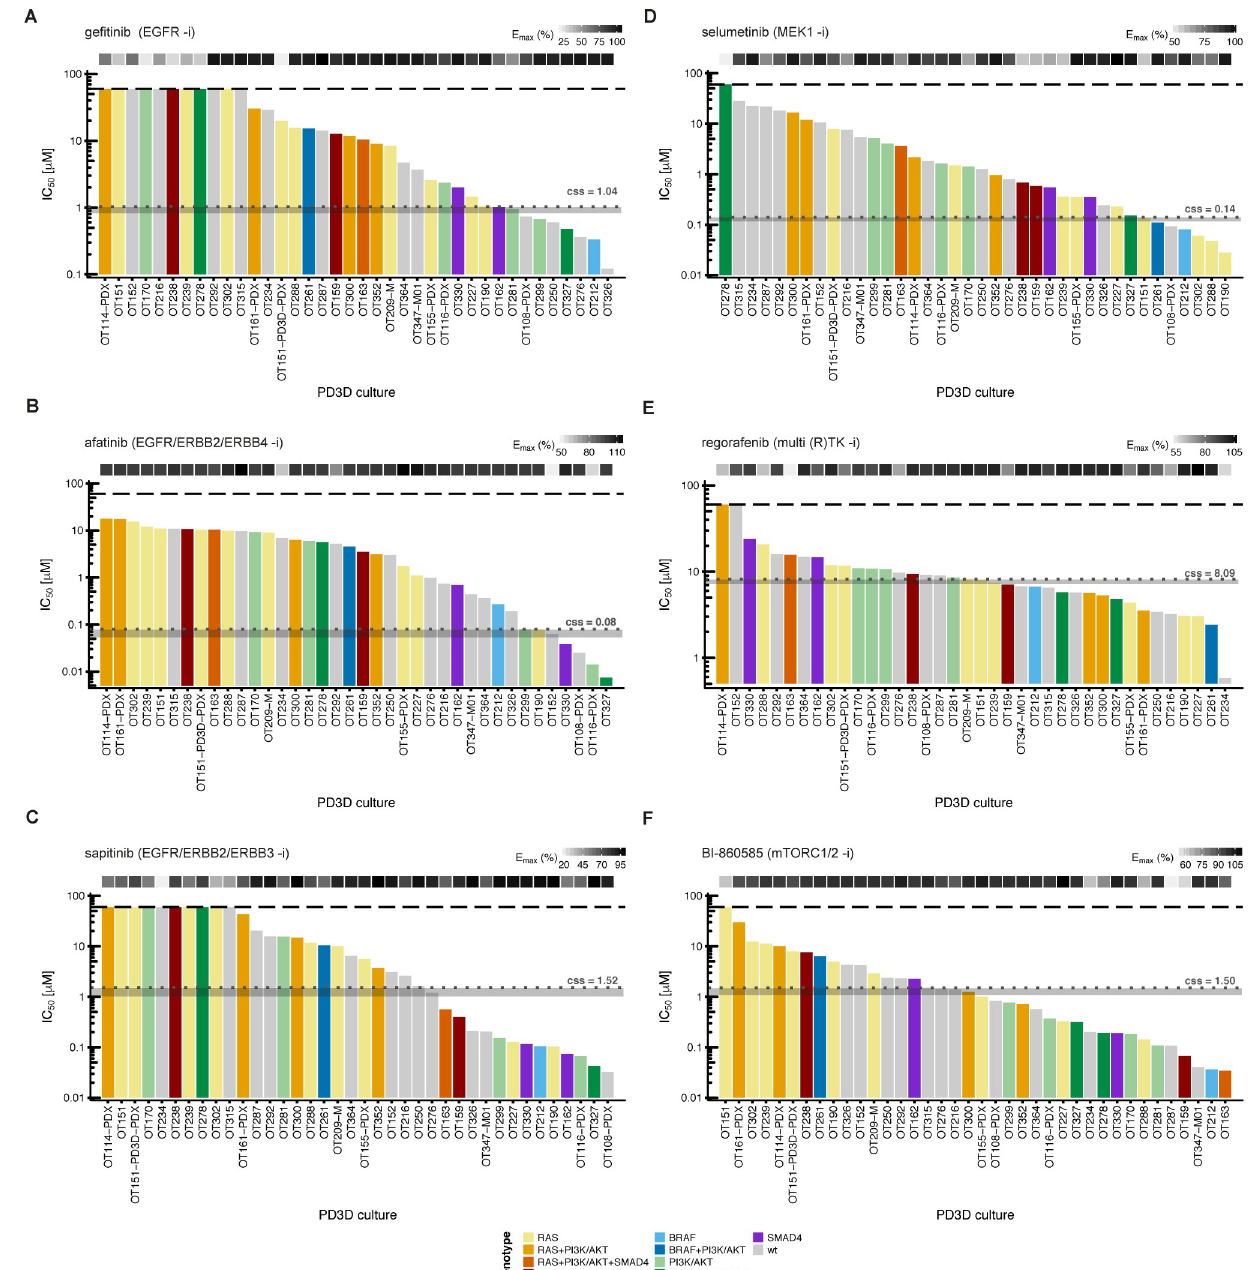
Fig 2. In vitro drug response waterfall plots of 38 organoid cultures show individual patterns of resistance and sensitivity. IC 50 values for 38 in vitro models were determined with a semi-automated drug response assay platform. The lower and upper assay cutoffs were 0.003 μ M and 60 μ M. Drug efficacy (E max ) was included as additional measure of response, indicated with light grey to black boxes according to percent efficacy above the waterfall plot. The genotype of each culture according to panel sequencing is color-coded according to the legend given at the bottom of the figure. Area (grey) of achievable steady state in vivo plasma concentrations (c ss ) are given in μ M and indicated with grey dotted lines. (A-C) IC 50 values for small molecules gefitinib, afatinib and sapitinib, targeting the ERBB receptor(s) ERBB1/EGFR, ERBB2/Her2, ERBB3 and ERBB4. (D) Inhibition at the level of MEK1/2 with selumetinib. (E) Response to the multikinase inhibitor regorafenib. (F) Treatment with the mTORC1/2 inhibitor BI-860585. The BRAF G466R and BRAF G466V mutations in tumors OT170 and OT327, respectively, are not included in the figure, as their gene products are considered kinase-dead [77].